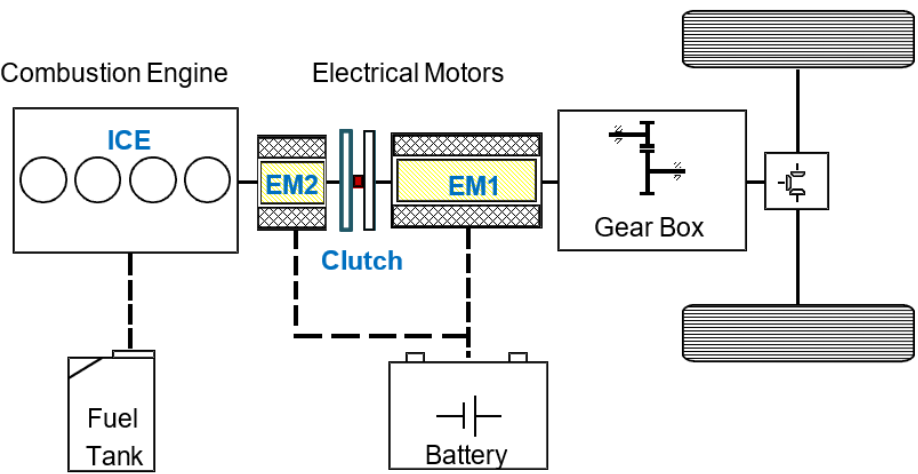
Figure 1. Hyundai 2021 Sonata Hybrid.